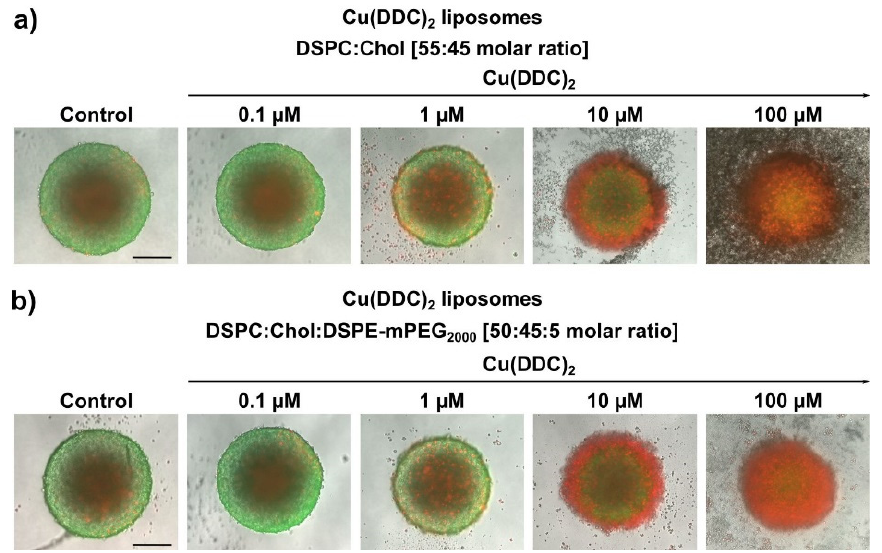
Figure 9. Representative fluorescence microscopy images of 3D LS monoculture spheroids on the basis of live/dead staining. 3D LS spheroids were treated for 72 h with non-PEGylated ( a ) and PEGylated ( b ) Cu(DDC) 2 liposomes. The spheroids were stained with a combination of two dyes: 1 µM calcein-AM and 5 µM PI, added 2 h prior to the end of liposomal treatment. Calcein-AM (green) is visible at the outer cell layer, indicating highly proliferating and viable cells. PI (red) is primarily located in the inner core, indicating necrotic and dead cells. With increasing doses of Cu(DDC) 2 liposomes, the PI signal intensified in the outer proliferating cell layer, until reaching the necrotic core. Scale bar = 200 µm.